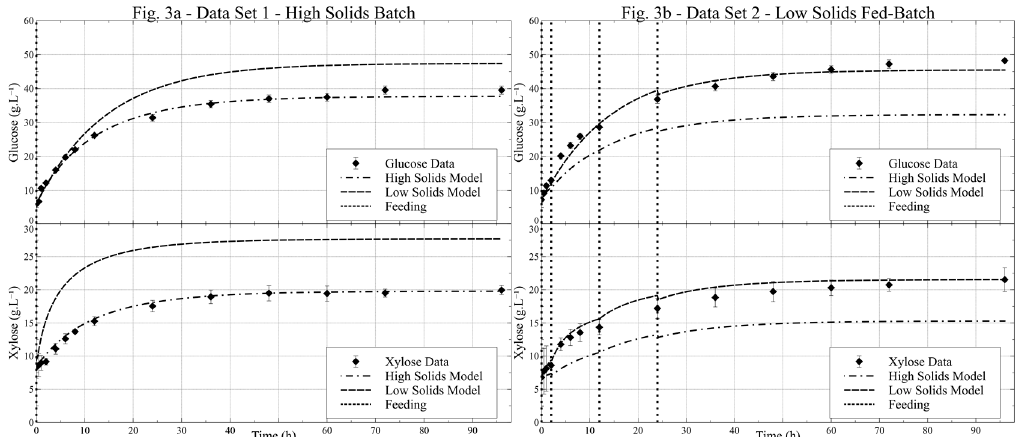
Figure 3. High solids model and low solids model fitting—( a ) Models prediction for Data Set 1; ( b ) Models prediction for Data Set 2; error bars in data points are the standard errors between experiment’s duplicates for the compound concentration; vertical dotted lines are the solids feeding times. Table 2. High and low heterogeneous Michaelis-Menten model parameters—parameter ± standard error. Table 3. High and low heterogeneous Michaelis-Menten model parameters—parameter ± standard error.